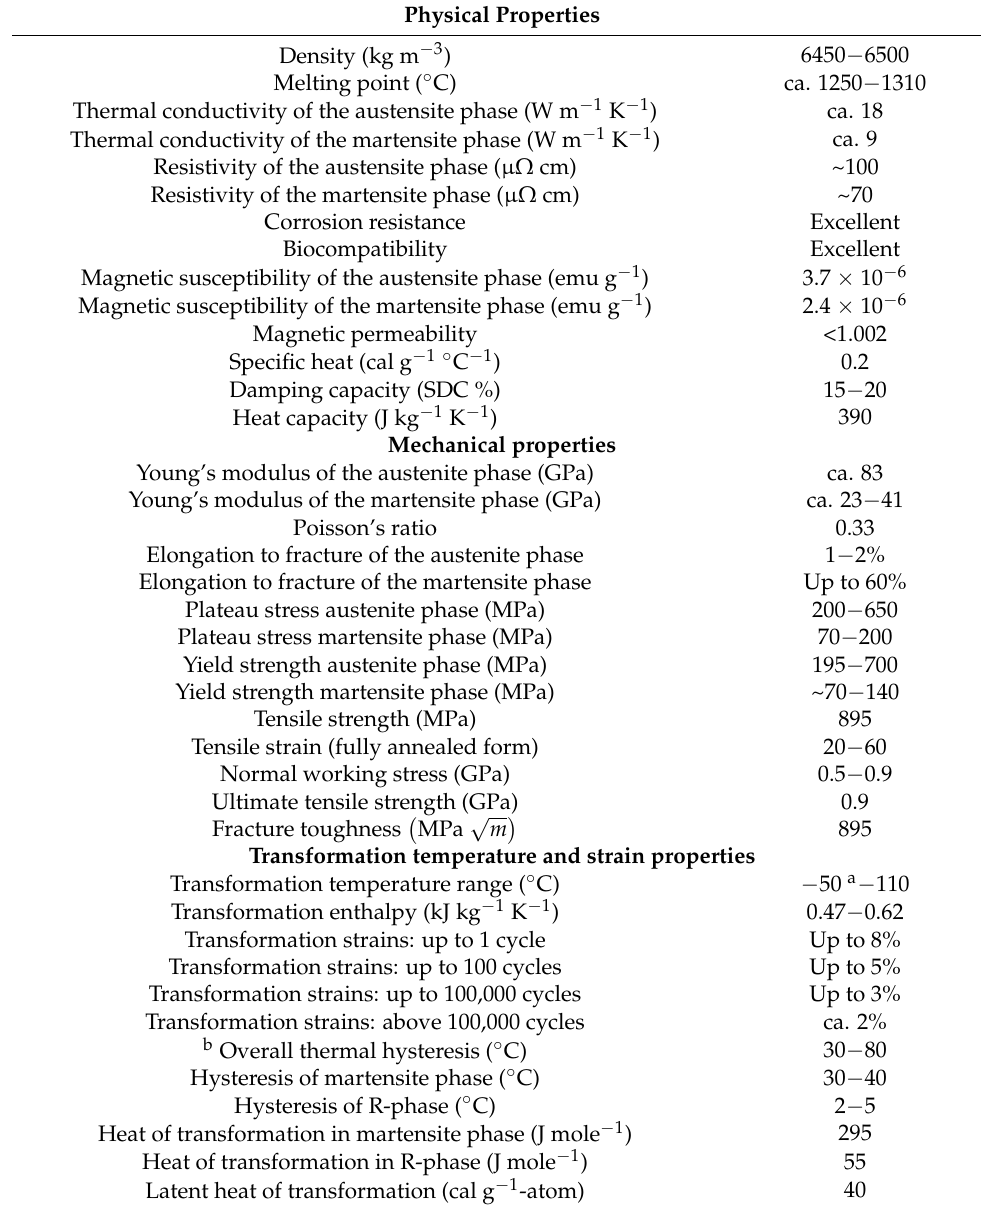
Table 1. Characteristic physical, mechanical, and thermal transformation properties of NiTi-based SMAs